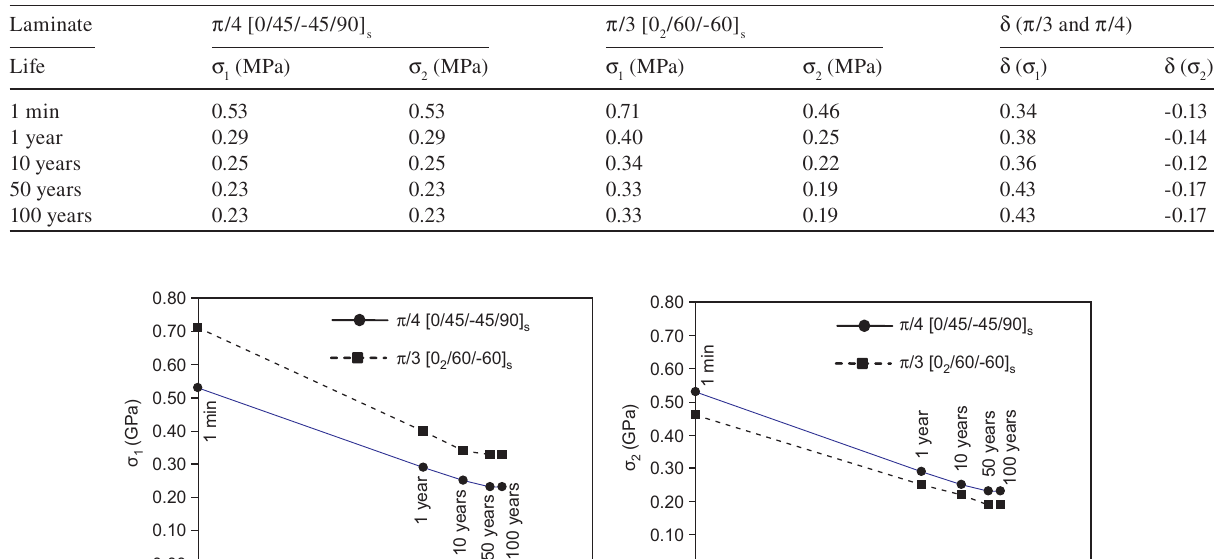
and σ failure stresses at different life for π /3 and π /3 laminates. 1 2